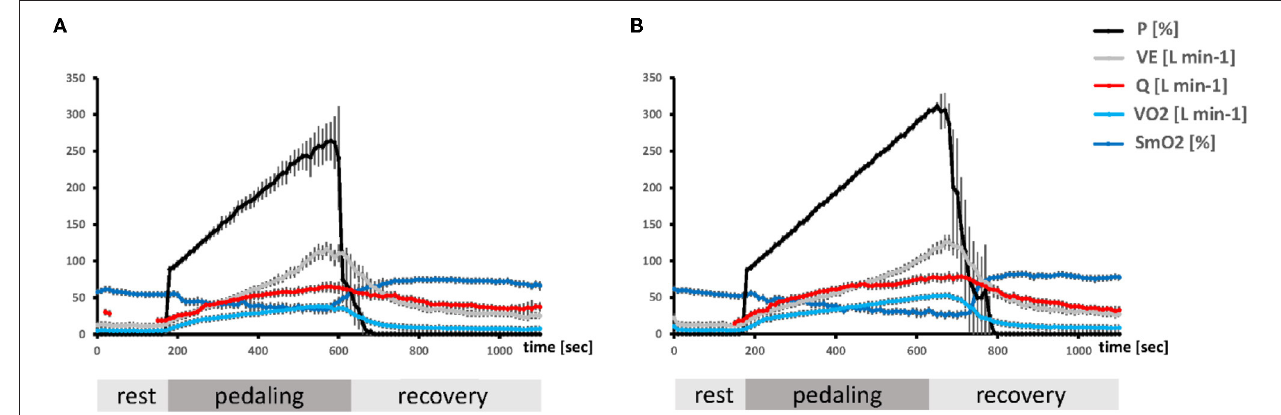
FIGURE 1 | Timeline of the average metabolic alterations during the ramp test. Composite line graphs visualizing the mean + SE over 10-s-intervals of the ramp exercise test for selected parameters characterizing aerobic metabolism and PO in unfit (A) and aerobically fit (B) subjects. Values during the pedaling phase were scaled to the respective average duration during which subjects were able to resist voluntary exhaustion. The Y-axes indicate the numerical values for each parameter.